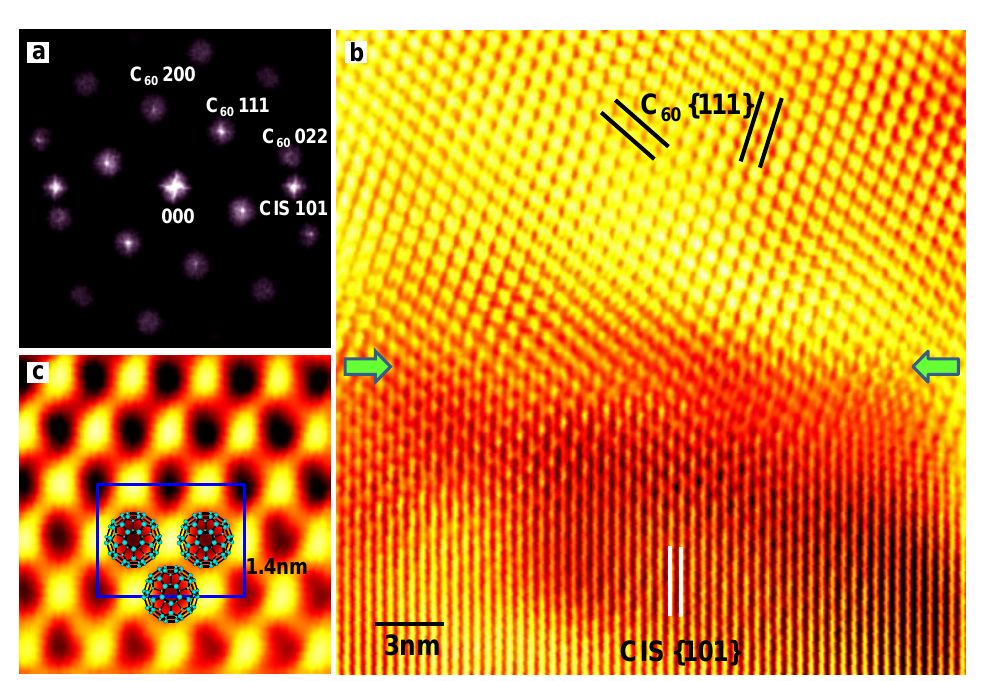
Figure 11. (a) Filtered Fourier transform of HREM image of CIS:C